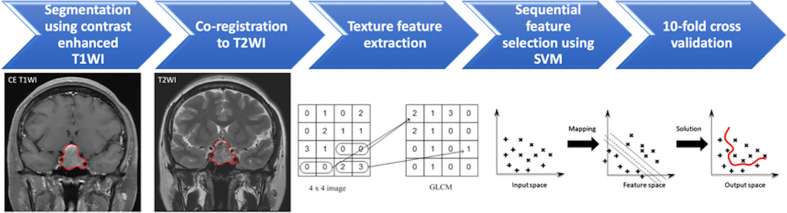
Flowchart of the analytical process for prediction of progression/recurrence (P/R) in non-functioning pituitary macroadenomas (NFPAs). The NFPA (red outline) is segmented on coronal contrast-enhanced (CE) T1WI and then mapped to the coronal T2WI. On each set of images, a total of 107 imaging features, including 32 first order features and 75 textural features, are extracted. The most important three features are selected by sequential feature selection and support vector machine (SVM) classifiers to build the prediction model. A 10-fold cross validation method is applied to test the model performance.